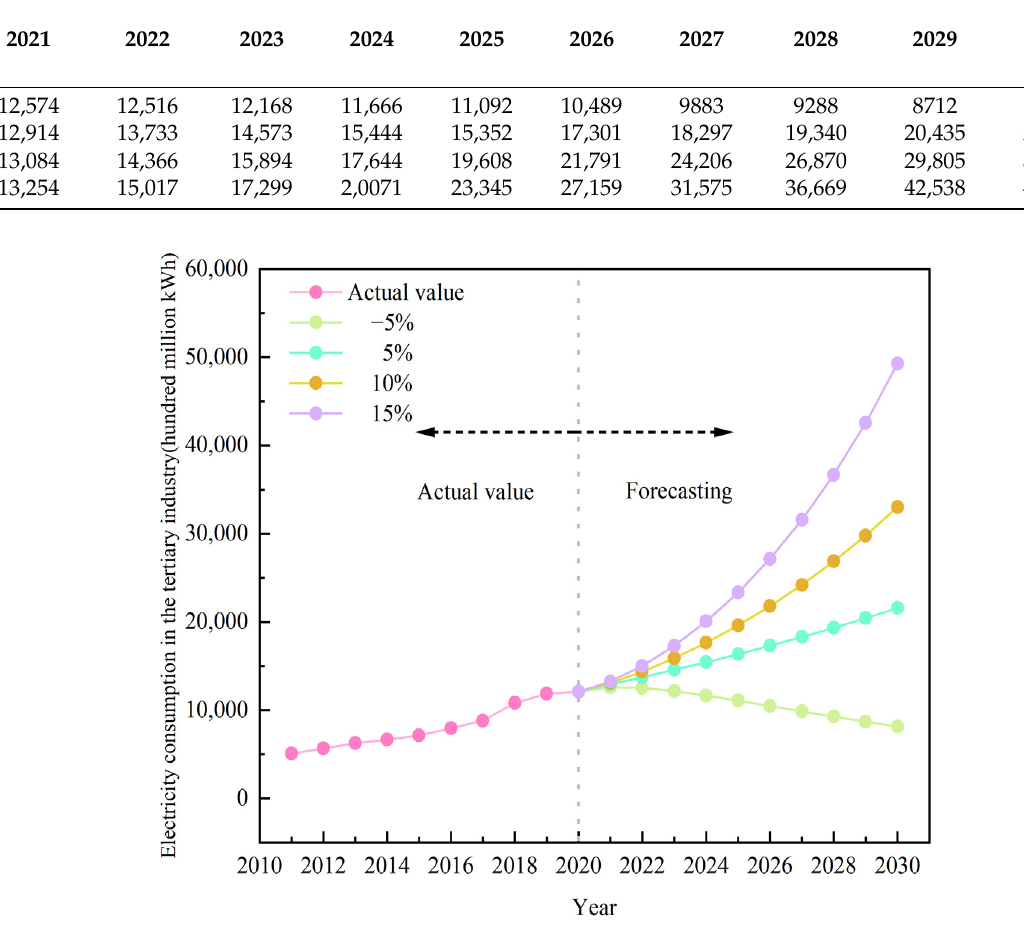
Figure 3. Forecast results of power consumption of China’s tertiary industry.